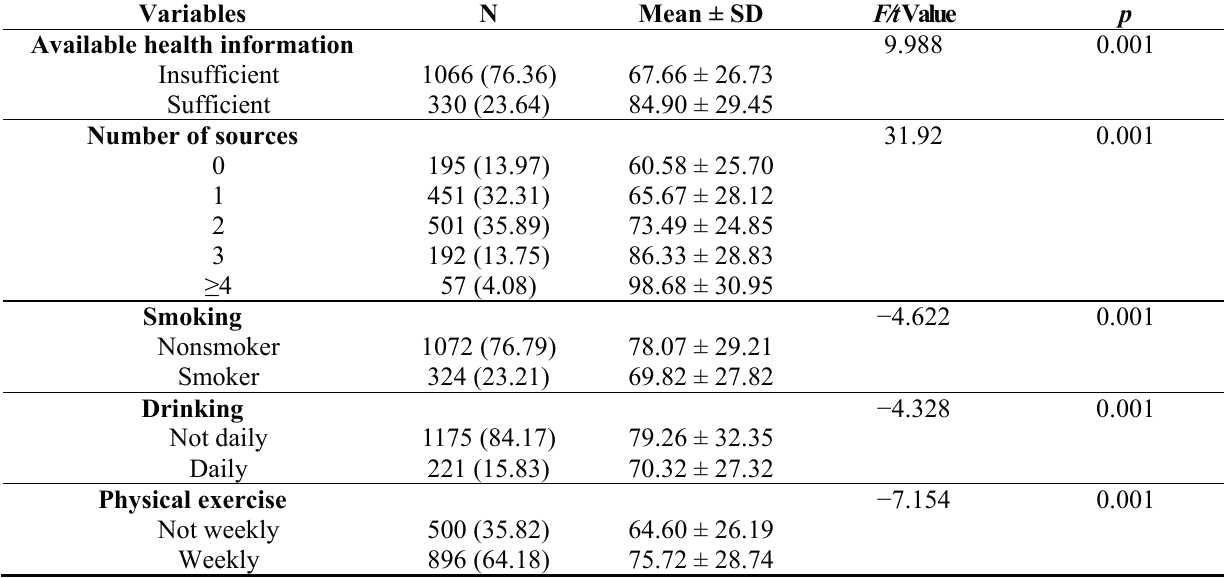
Table 2. Relationships of the health literacy score with health-related behaviors and health